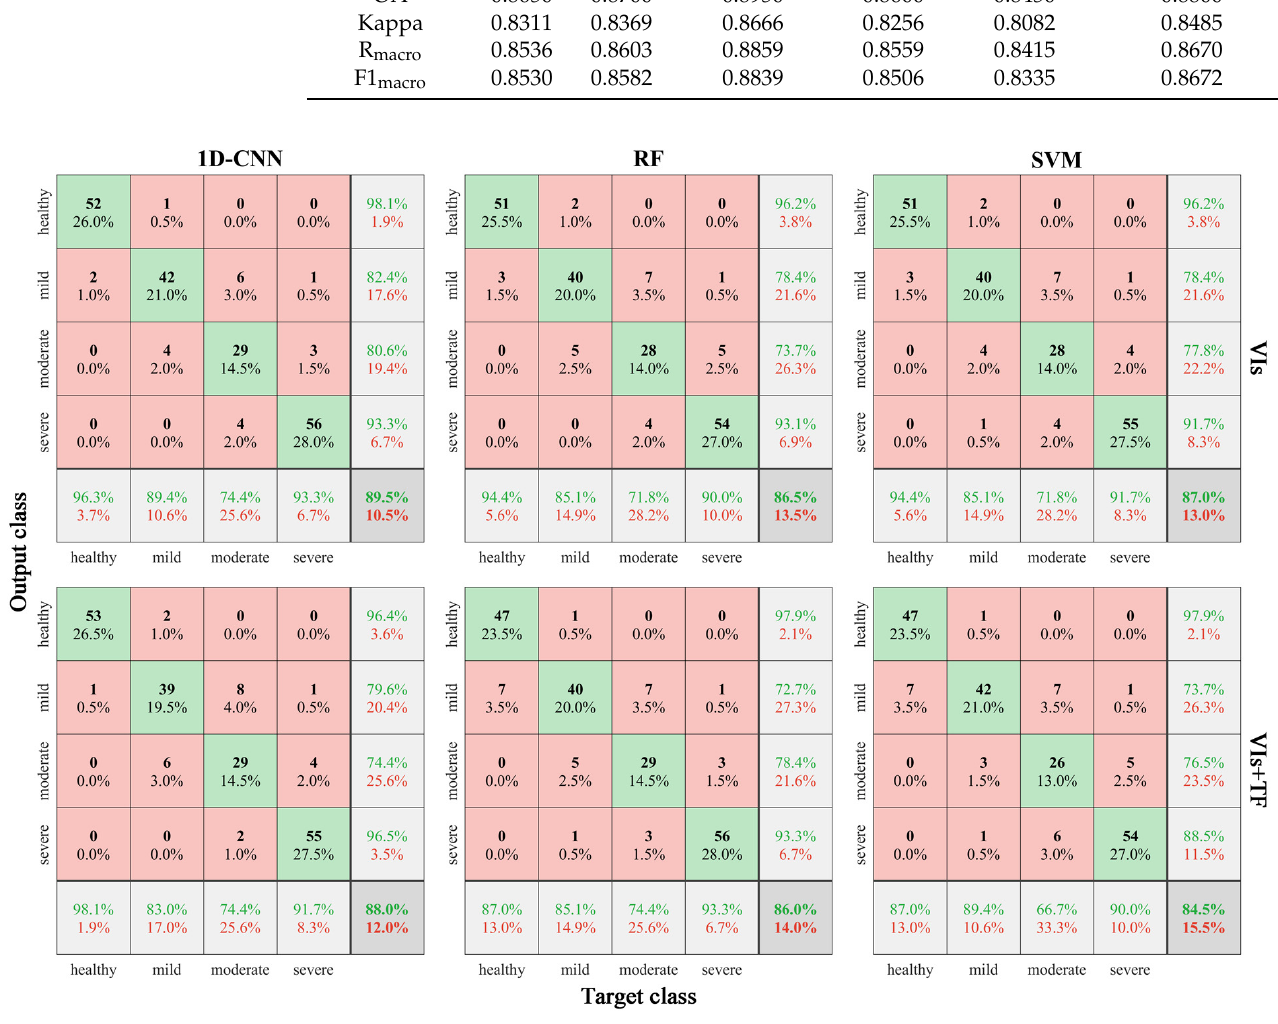
Figure 6. Confusion matrices of different classification models for forest tree damage severity.